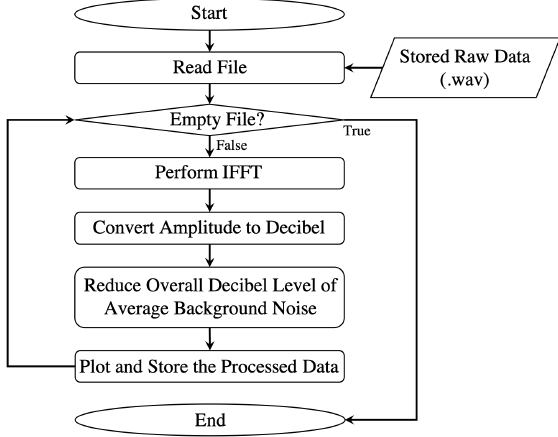
Figure 6. Data processing flow for the first version of the radar